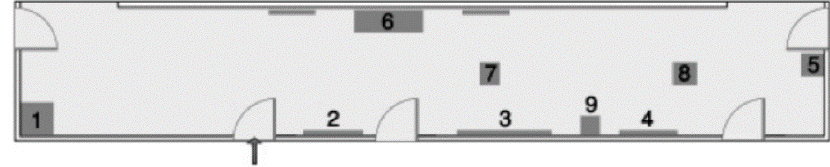
Figure 1. Simple space.